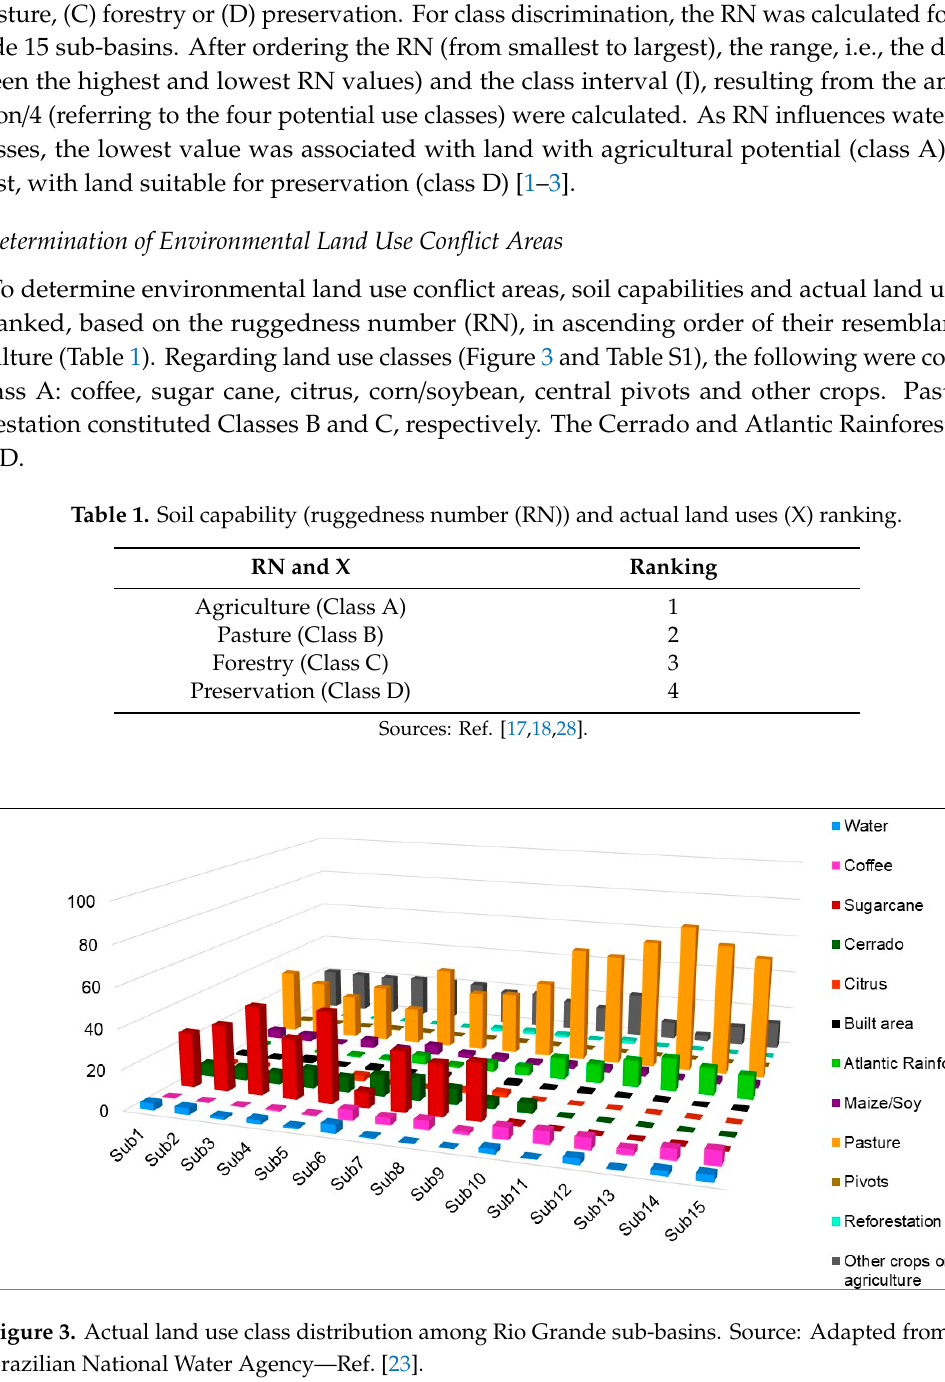
Table 3. Morphometric Rio Grande sub-basin characteristics.